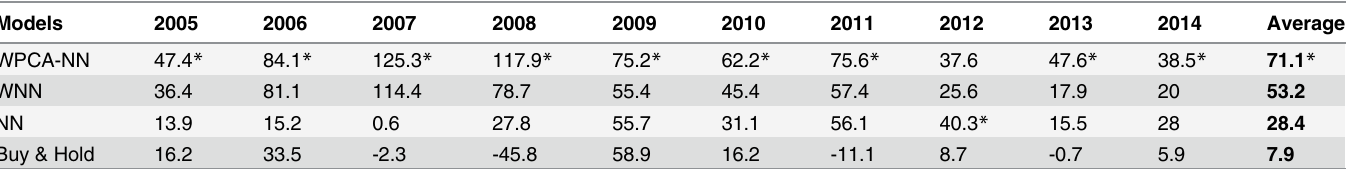
Table 10. Profit of the models, results for SiMSCI futures. Models